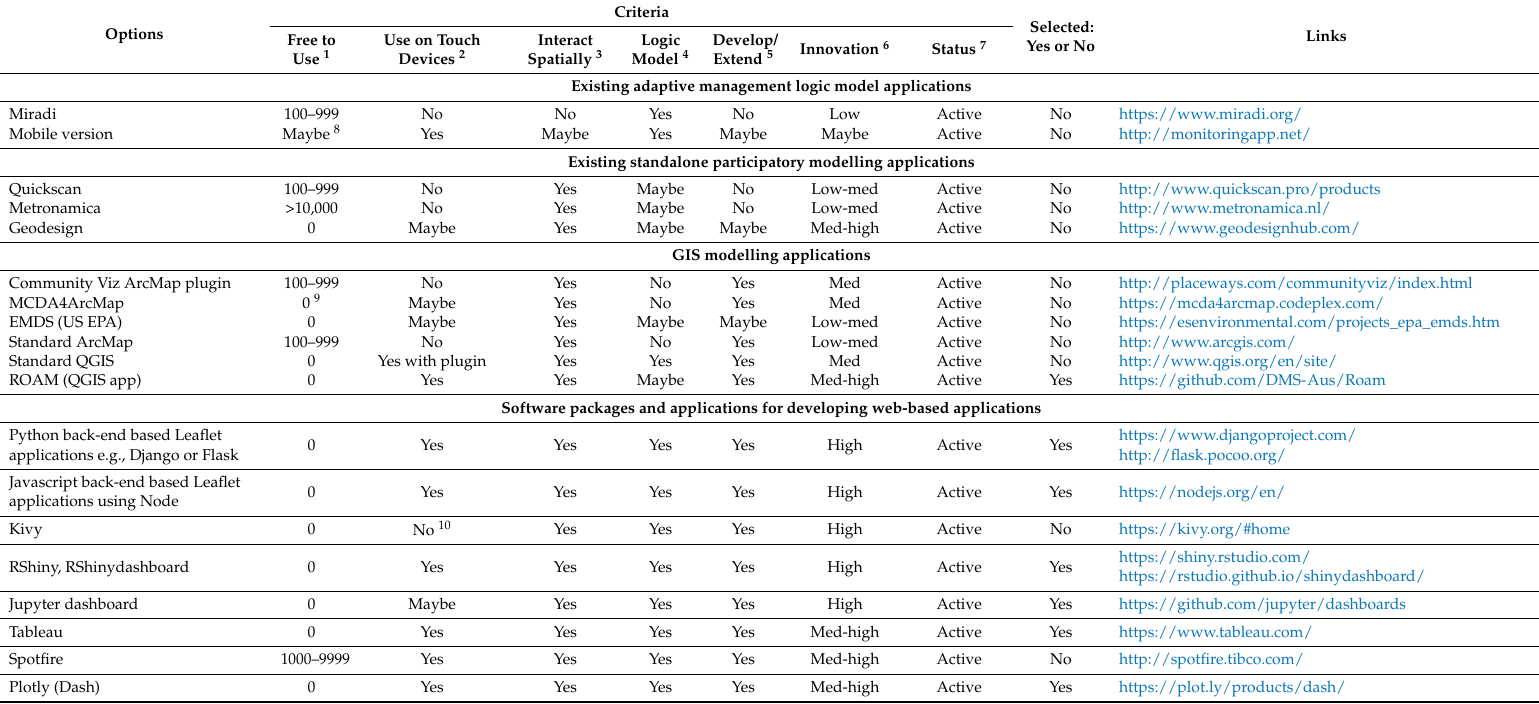
Table 1. Assessment of software options for tool